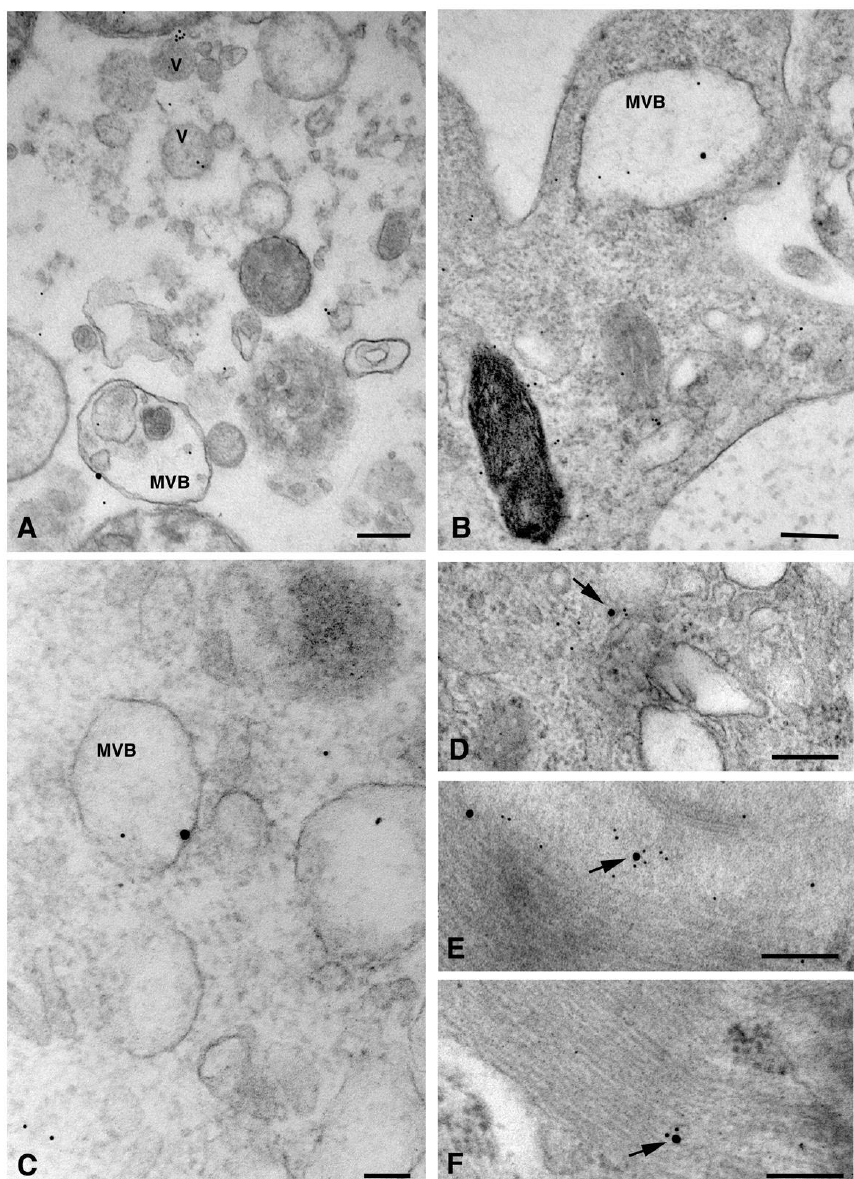
Figure 3. TEM double immunogold analysis for Cx26 (10 nm gold particles) and flotillin or CD63 (20 nm gold particles) on cytoplasmic vesicles. ( A – C ) Representative images of dH9c2 cells showing double immunoreaction for Cx26 and flotillin ( A , B ) and for Cx26 and CD63 ( C ) on multivesicular bodies (MVB). ( D – F ) Heart sections showing double immunoreactivity for Cx26 and flotillin ( D , E ) and for Cx26 and CD63 ( F ) on small vesicles (arrows) sometimes associated with sarcomeres ( E , F ). Scale bars 200 nm ( A , B , D – F ), 100 nm ( C ). V, vesicles.